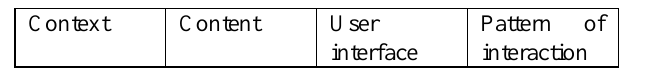
Table 1. Mintz' Four Museum Media